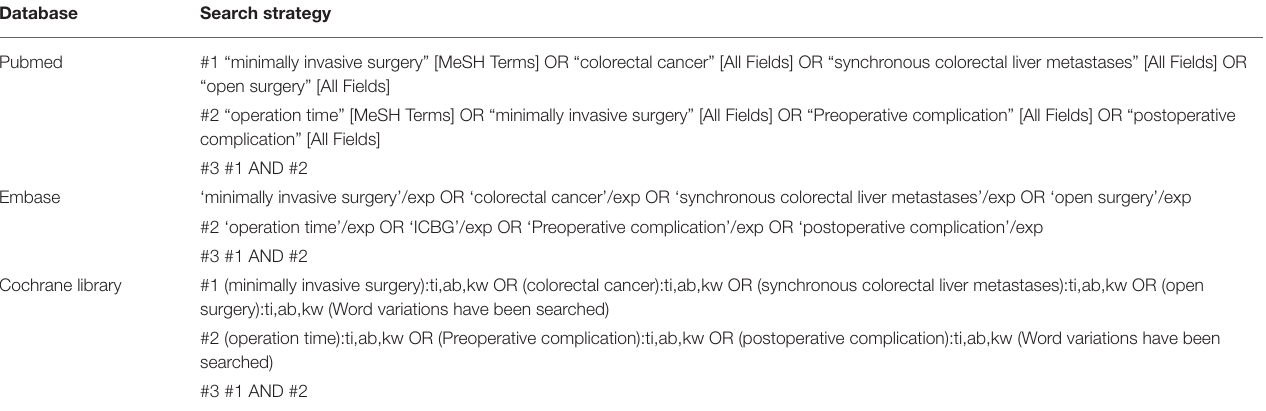
TABLE 1 | Search strategy for each